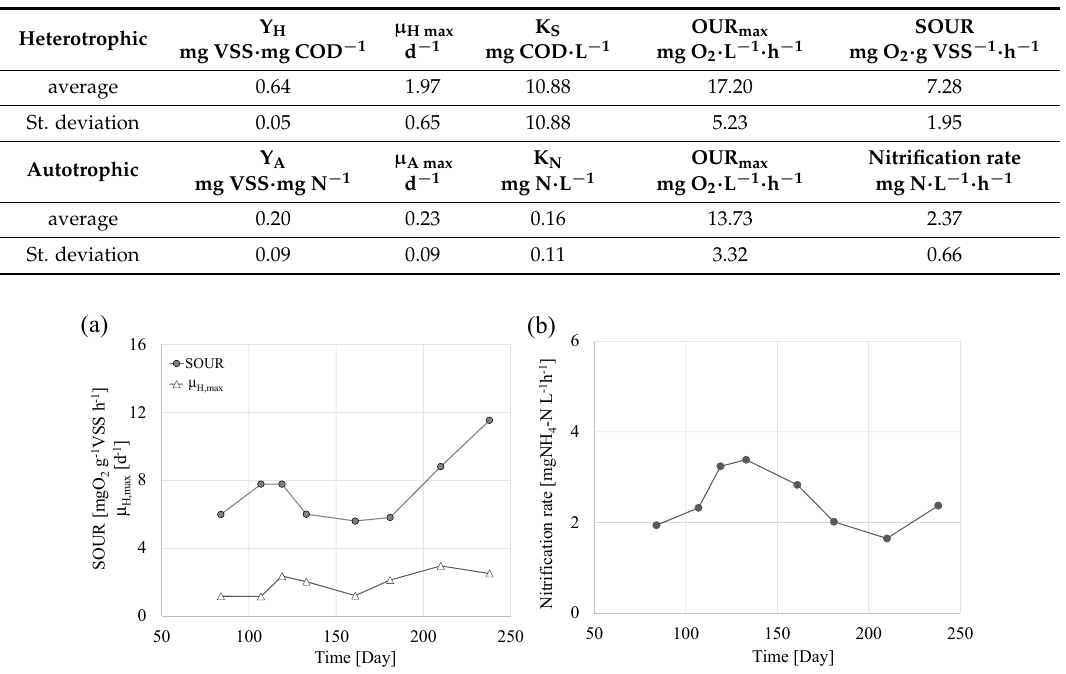
Figure 6. Nitrate production and ammonium removal efficiency throughout experiments.